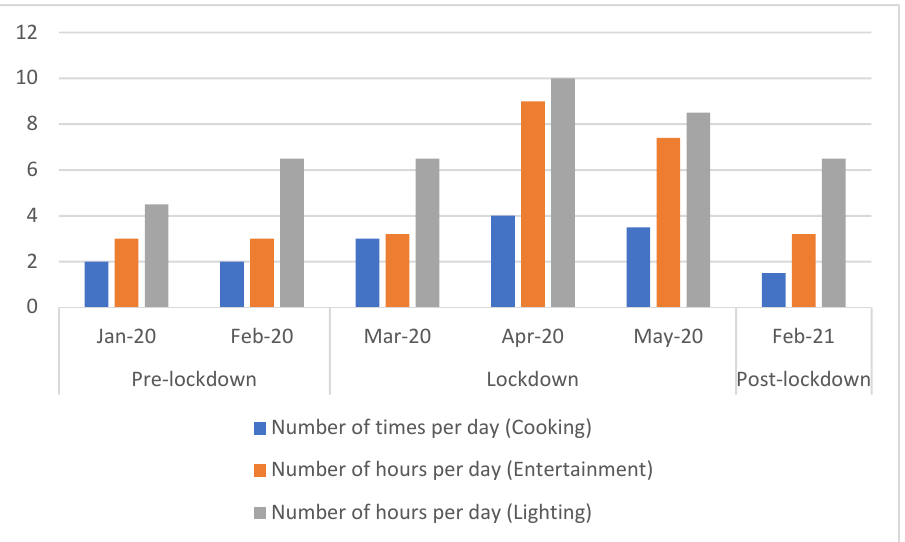
Figure 4. Results of a pilot study from January-May 2020 and February 2021 for cooking, entertain- ment, and lighting behavior patterns for pre-lockdown, lockdown, and post-lockdown periods.